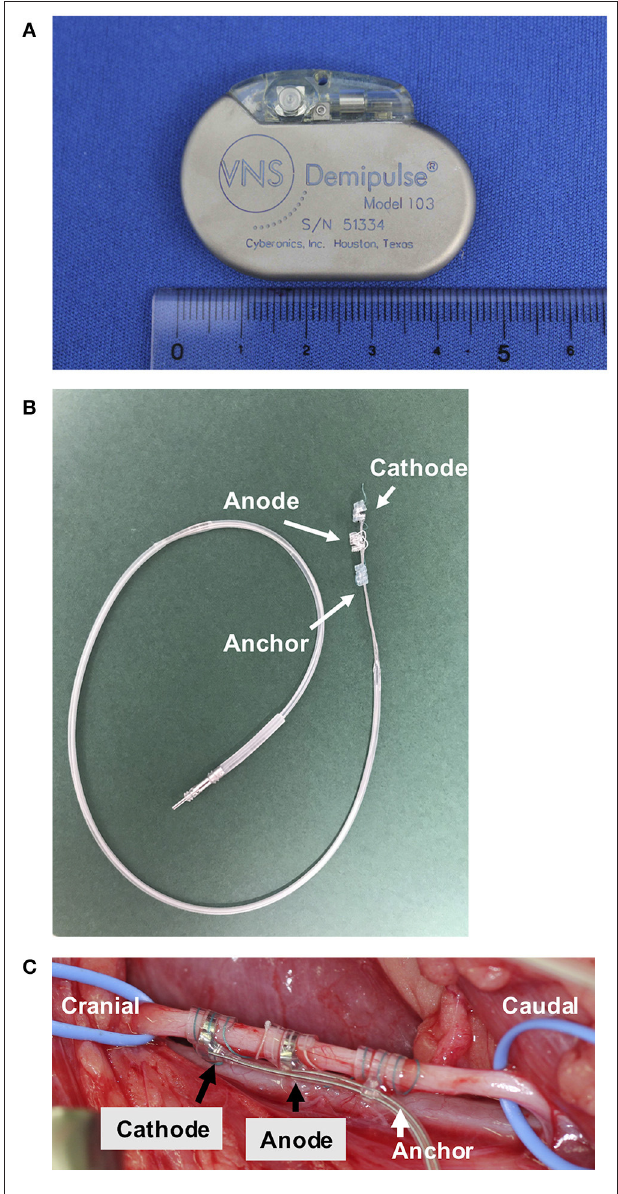
FIGURE 1 | The VNS device and an intraoperative photograph of the left vagosympathetic trunk. The pulse generator (width 45mm, height 32mm, depth 6.9mm, and weight 16g) (A) . The electrode (B) . The left vagosympathetic trunk wrapped by the two helical electrodes and anchor tether (C) . VNS, vagus nerve